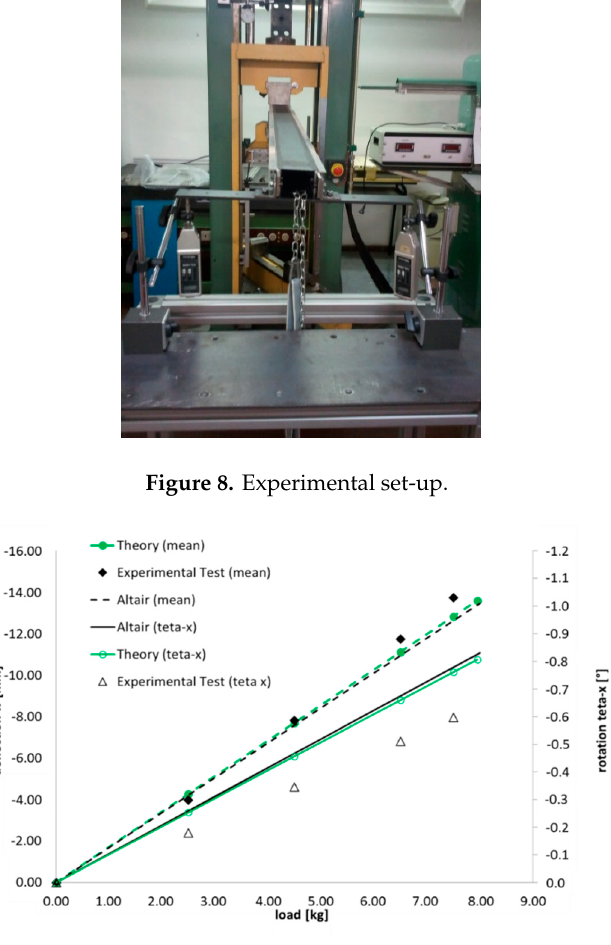
Figure 9. Fem and theoretical results vs. experimental results.